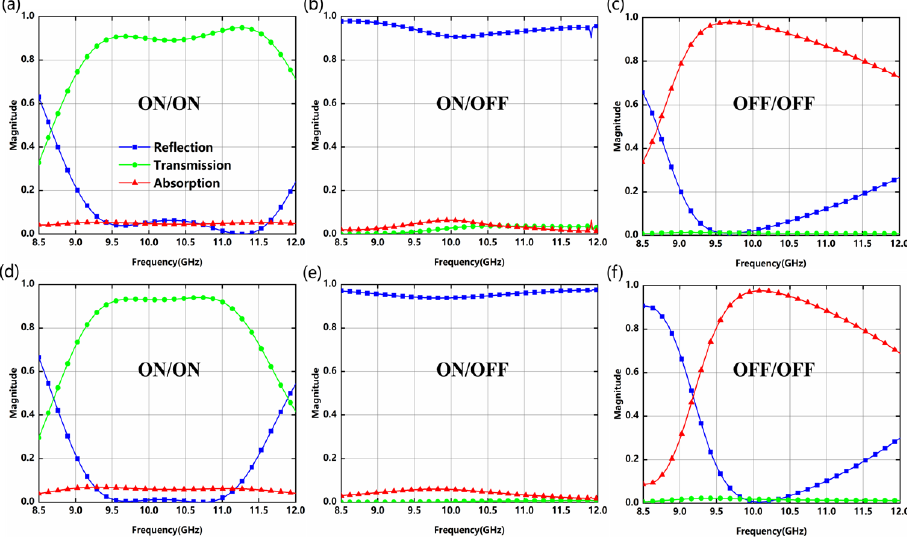
Figure 2. Transmission, reflection, and absorption for different states of the PIN diodes in the ( a – c ) x-direction and ( d – f )